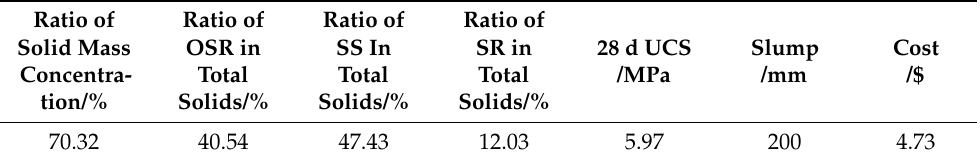
Table 2. Optimum mixing ratio and test data for